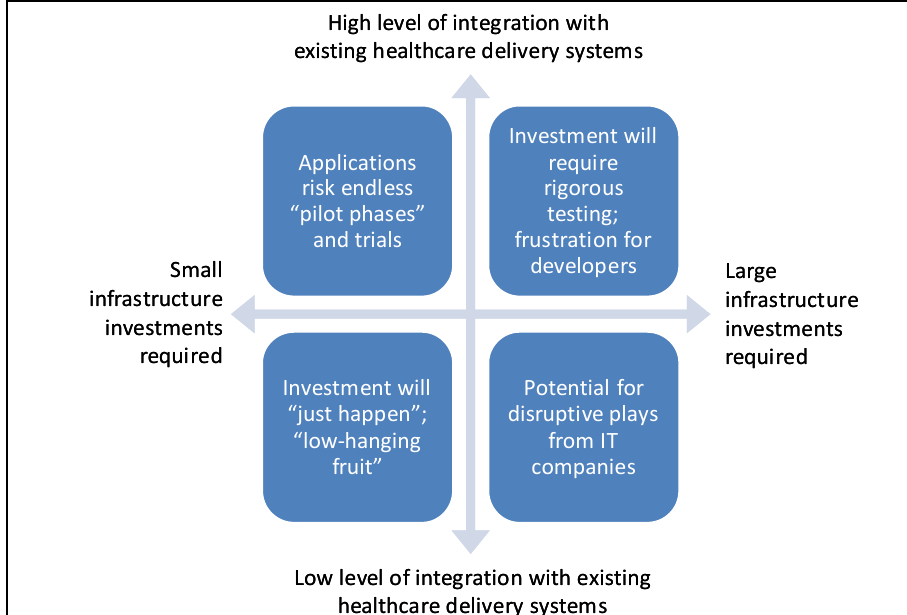
Figure 19: Segmentation of mHealth